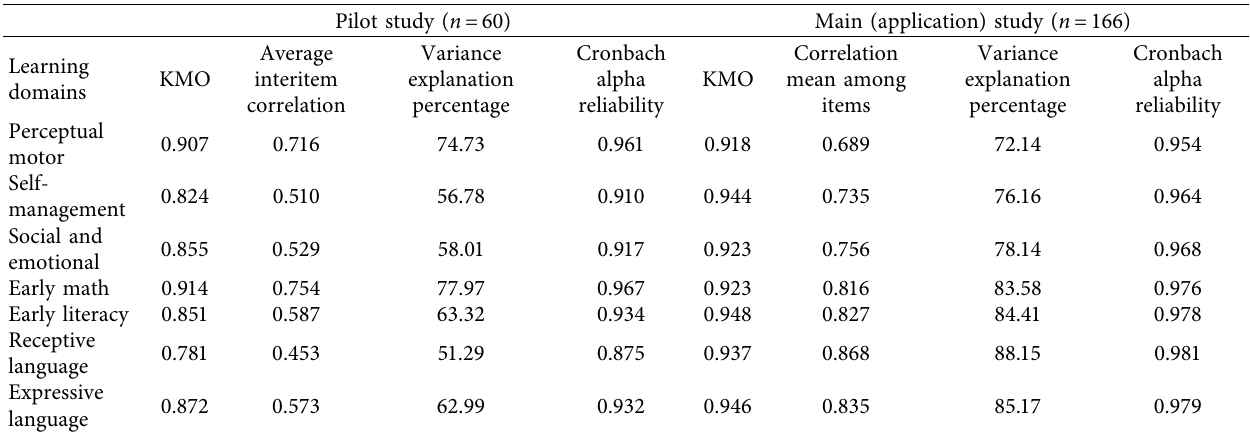
Table 6: Some statistical results of reliability